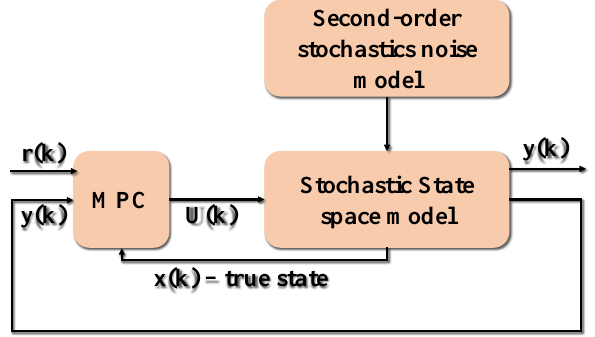
Figure 10. Stochastic MPC with second-order statistic noise model.